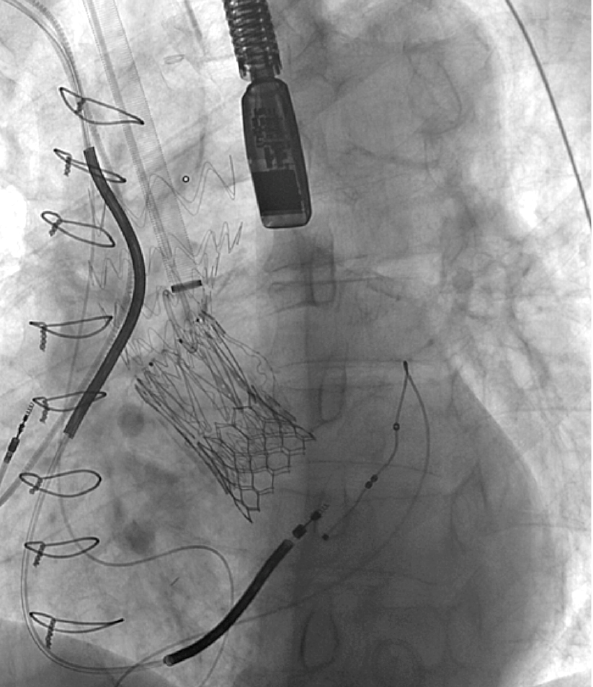
Figure 4. TEVAR fluoroscopy 3: final result with deployed JOTEC